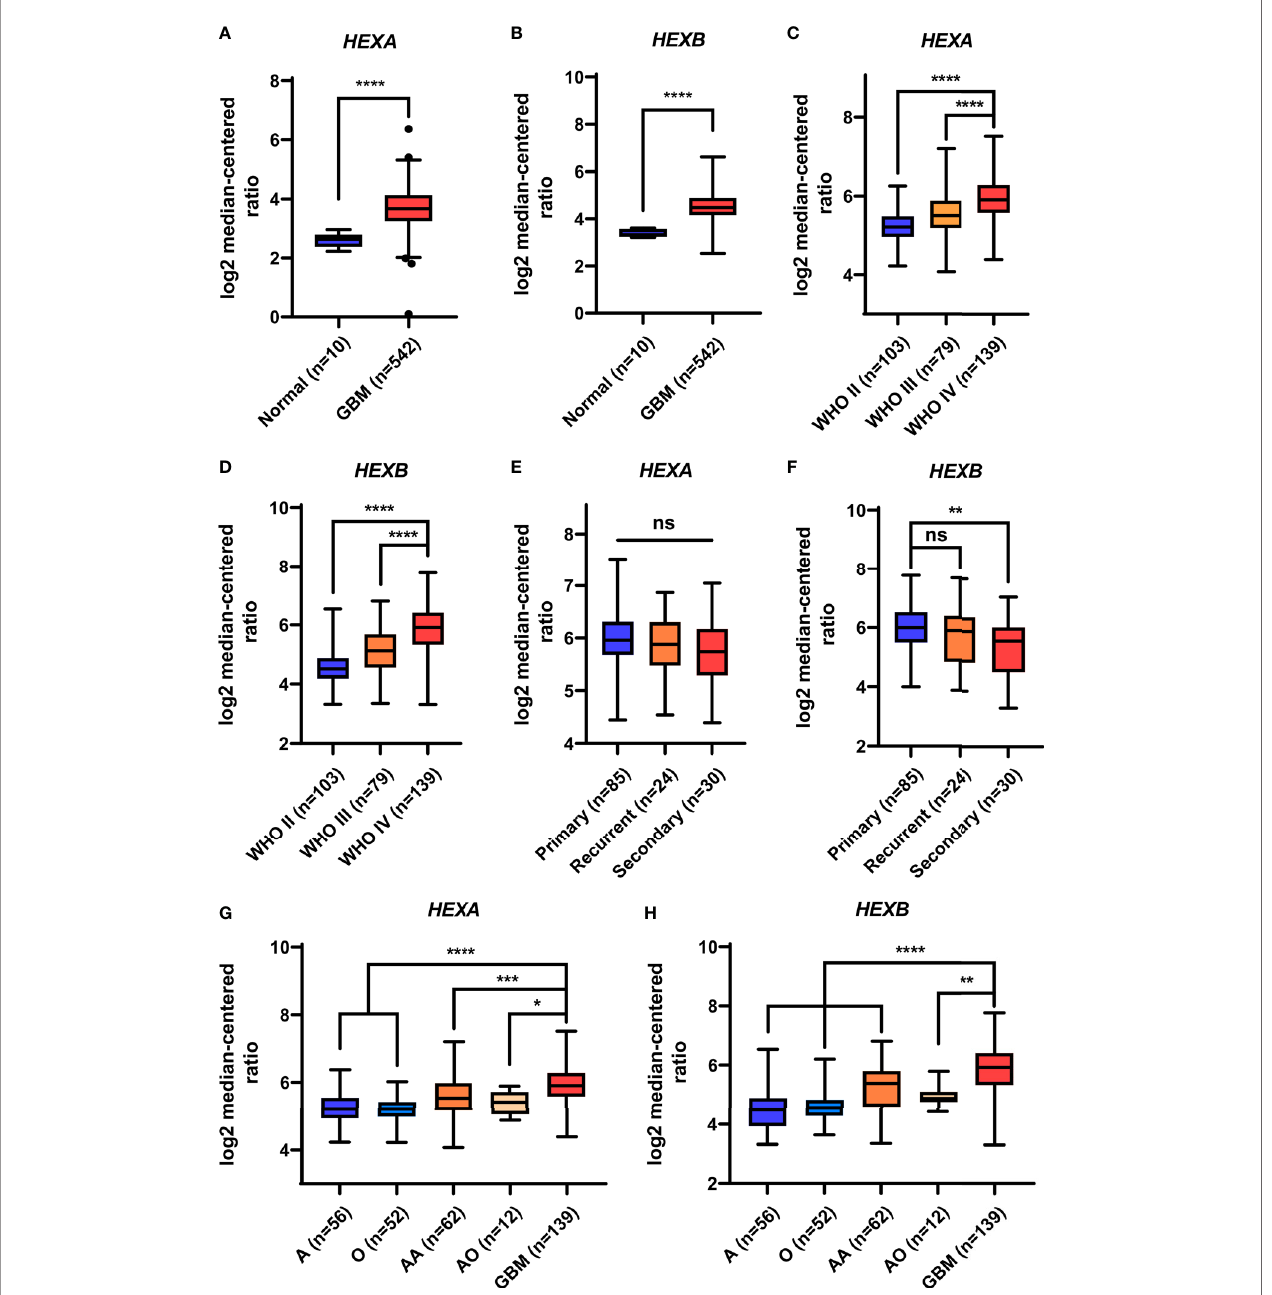
FIGURE 1 | Upregulation of mRNA levels of HEXA and HEXB in GBM based on Oncomine and CGGA database analysis. (A, B) Analysis of HEXA and HEXB mRNA expression in the Oncomine database (t-test, GBM vs Normal). (C – H) Analysis of HEXA and HEXB mRNA expression in the CGGA database (one-way ANOVA, WHO IV vs WHO II and WHO III, Primary vs Recurrent and Secondary, GBM vs A, O, AA and AO). A (diffuse astrocytoma), O (oligoastrocytoma), AA (anaplastic astrocytoma), AO (anaplastic oligoastrocytoma), GBM (glioblastoma). * p < 0.05, ** p < 0.01, *** p < 0.001, **** p < 0.0001, ns, not signi fi